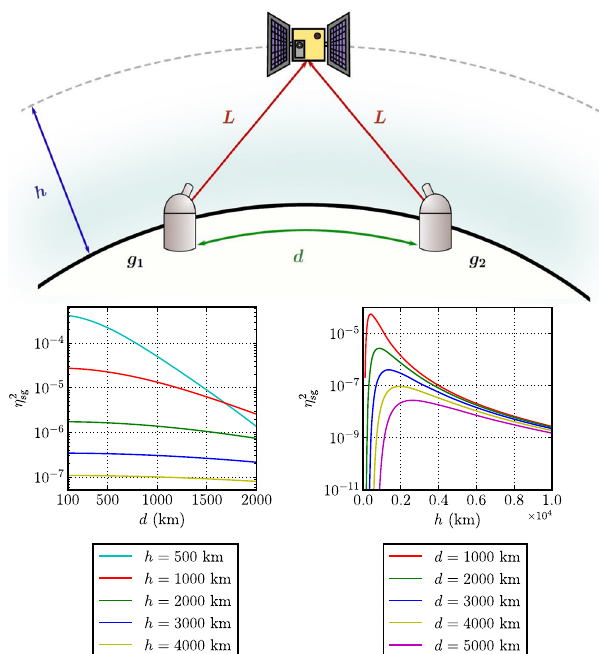
Fig. 8 Optical satellite-to-ground transmission. The total transmit- tance is given by η sg = η fs η atm , where the free-space transmittance η η fs given by eq. (9), and the atmospheric transmittance atm is given by eq. (11). Top — two ground stations g 1 and g 2 are separated by a distance d with a satellite at altitude h at the midpoint. Both ground stations are the same distance L away from the satellite, so that the total transmittance for two-qubit entanglement transmission (one . Bottom — plots of the qubit to each ground station) is η 2 sg as a function of d and h transmittance η 2 sg